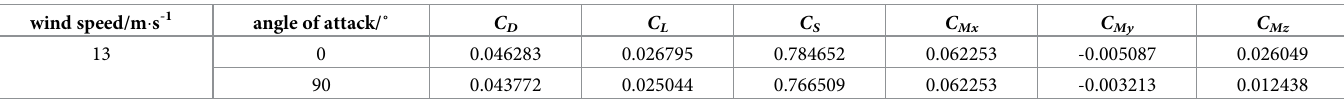
Table 2. Six-component coefficient of large bus.